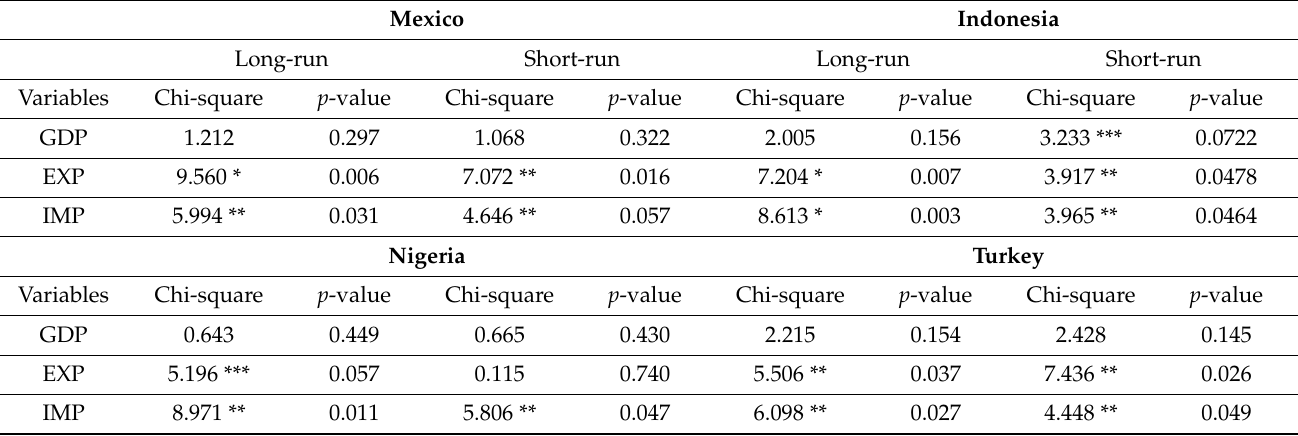
Table 8. Long-Run and Short-Run Asymmetric (Wald)